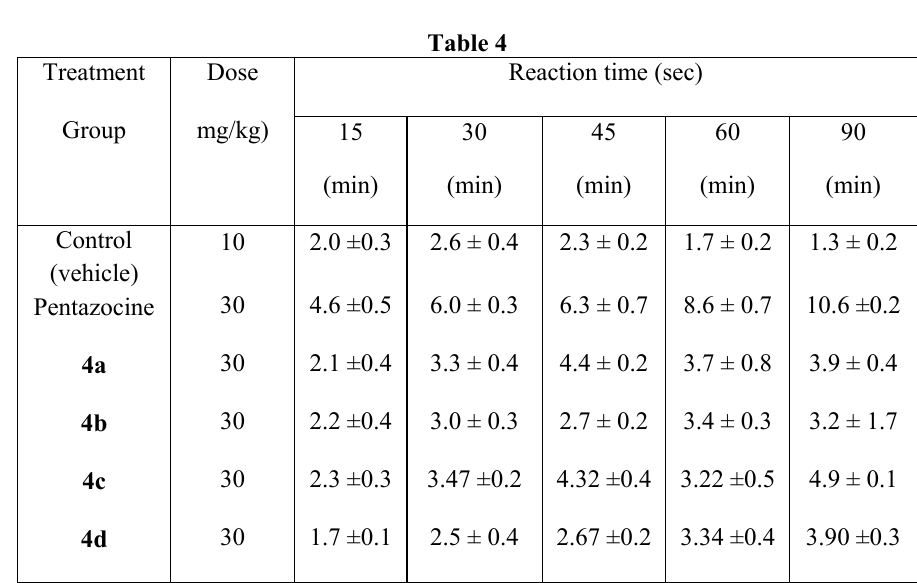
Table 3. Anti –Bacterial Activity of 1, 3, 4-thiadiazole derivatives against E.coli.